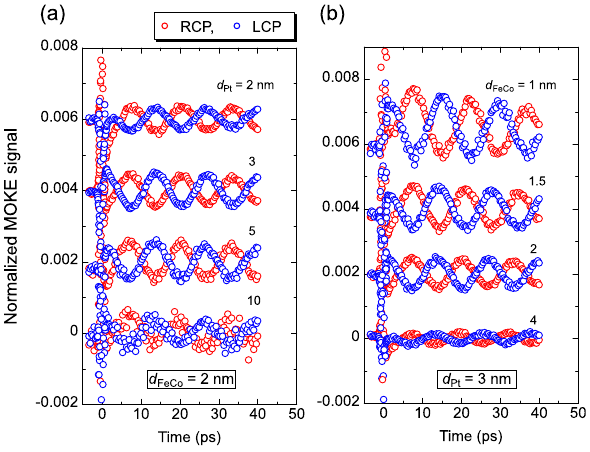
Figure 3: (a) Pt and (b) FeCo thickness dependence of optical helicity – induced magnetization precession for FeCo/Pt bilayer. The sample ( d Pt , d FeCo ) = (2, 3 nm) was measured